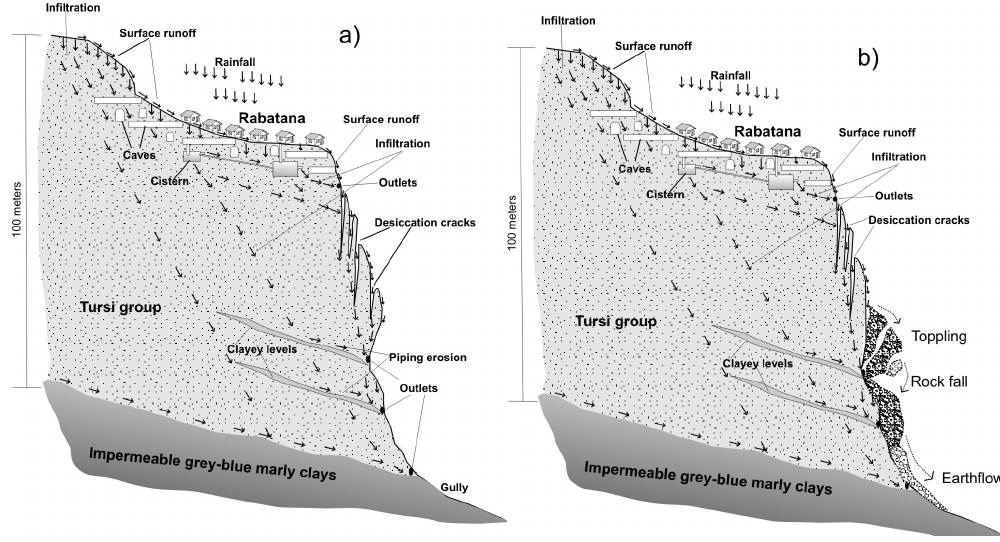
Fig. 10. Representative scheme of the evolution of the morphological processes acting on Rabatana slopes and subsurface. In (a) the predisposing elements to landslide and collapse phenomena are shown. The following morphological phase is shown in (b) where the main morphological effect is linked to the slope movements and cave collapses (after Lazzari et al.,